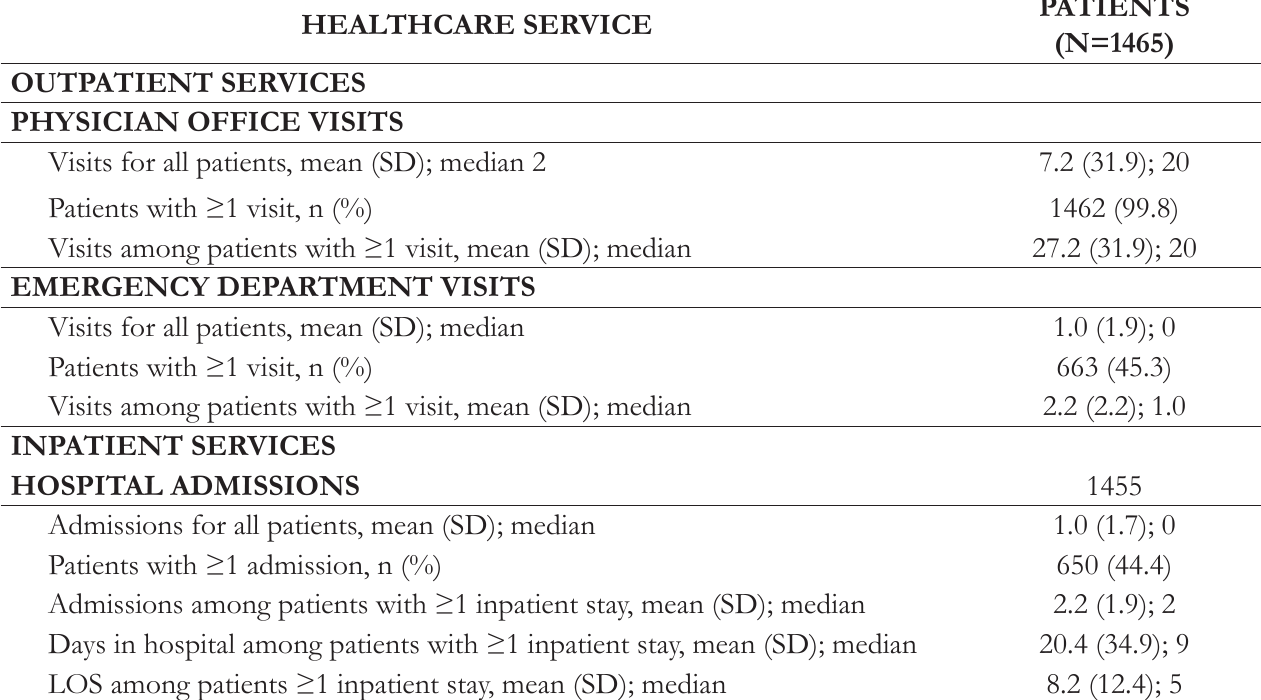
Table 3. All-cause Utilization of Healthcare Resources During 12-month Post-index Interval